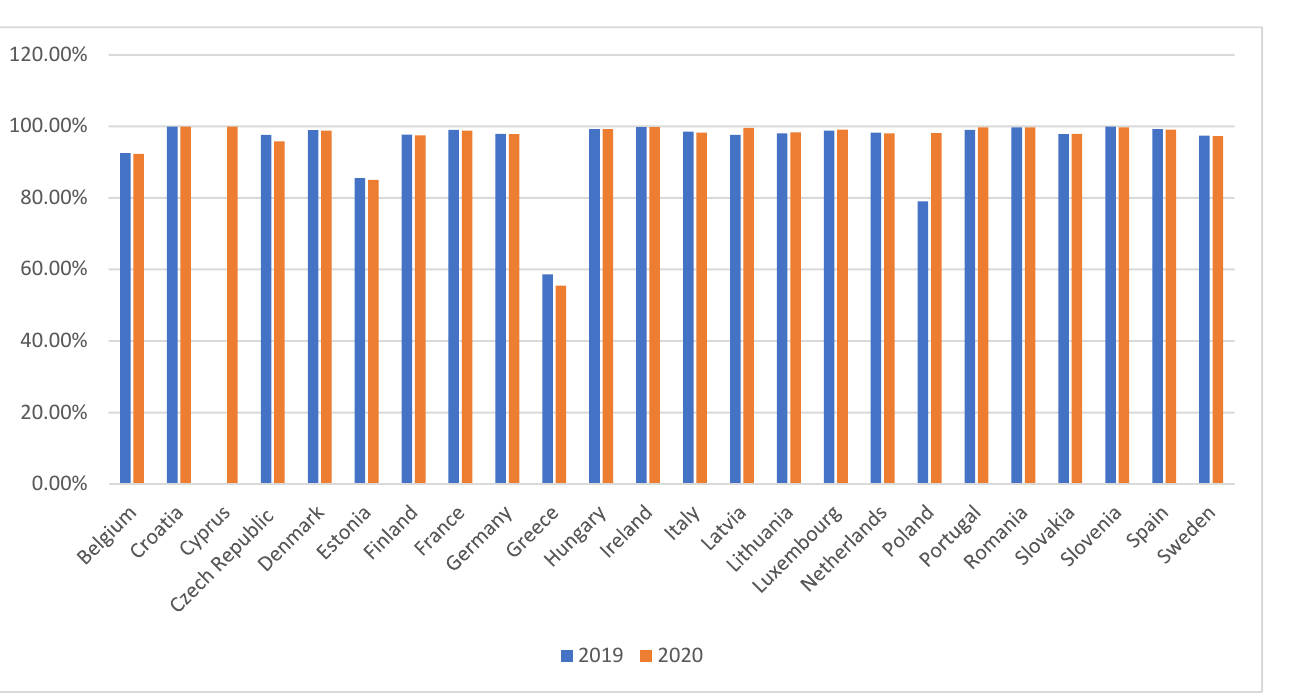
Figure 2. Medium and heavy duty diesel commercial vehicles in the EU [30,56]. (no data from some EU countries.).